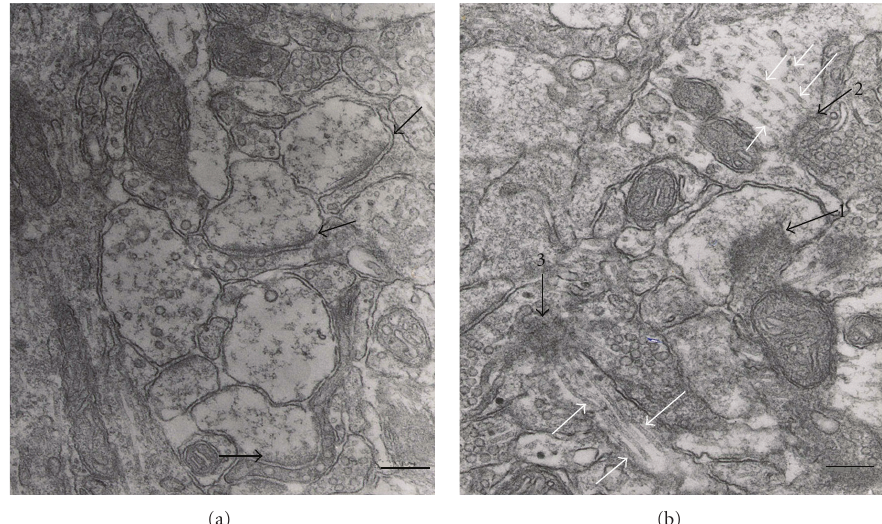
Figure 2: Redistribution of microtubules in dendritic spines after stimulation. There were little microtubules and thin postsynaptic densities (black arrows in (a)) in a nonstimulated slice (a). Many microtubules (white arrows in (b)) concentrated to three thickened PSDs (black arrows 1, 2, and 3 in (b)) in spines have emerged after stimulation (b). The planes of PSD1, 2, and 3 are perpendicular, oblique, and parallel to this electron microscopic section, respectively. Reprinted from Mitsuyama et al. (2008) [21] with permission. Bar, 150